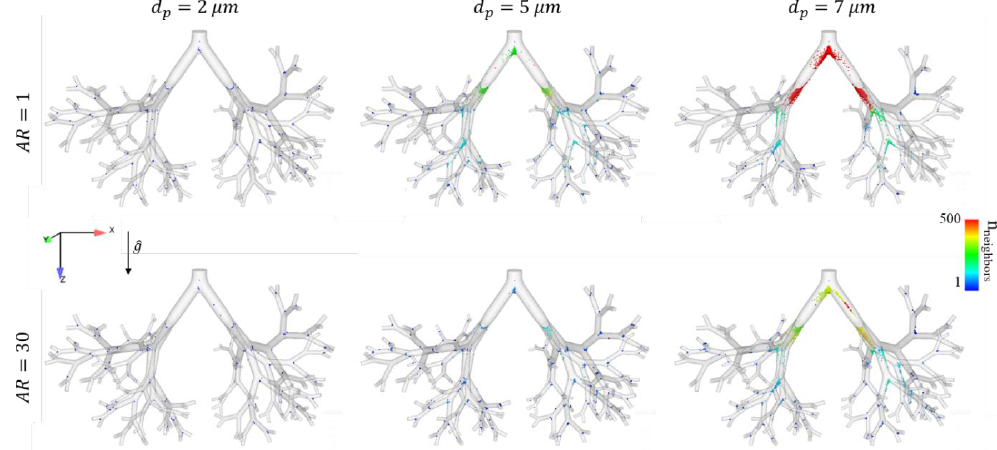
Figure 3. Deposition maps for fibers with different aspect ratios (rows) and equivalent diameters (columns) at the end of the DPI maneuver ( t = 3 s) in the nine-generation bronchial tree domain. Particle deposition is color coded (1–500) according to the number of neighbors within a 5 mm radius. It is clear that particles of d p > 2 µ m fibers deposit less and disperse more compared to spheres. We note that as d p increases, particles are strongly influenced by impaction and sedimentation at the carinas, causing them to be deposited, although they are more dispersed as the AR